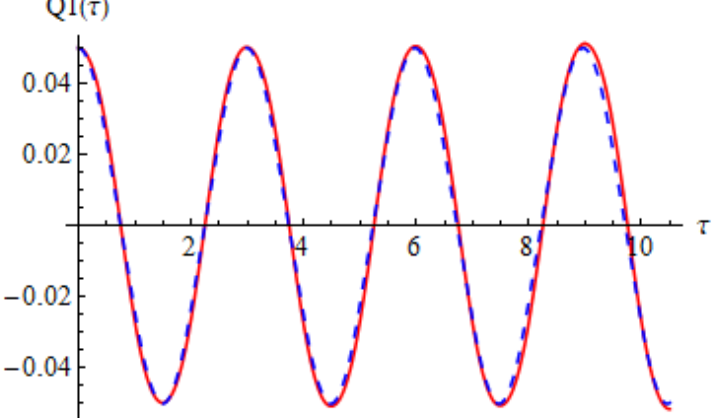
Figure 2. Comparison between the analytical solution (65) and numerical integration results for Equation (26): red solid line depicts numerical integration results while blue dashed line depicts analytical results.